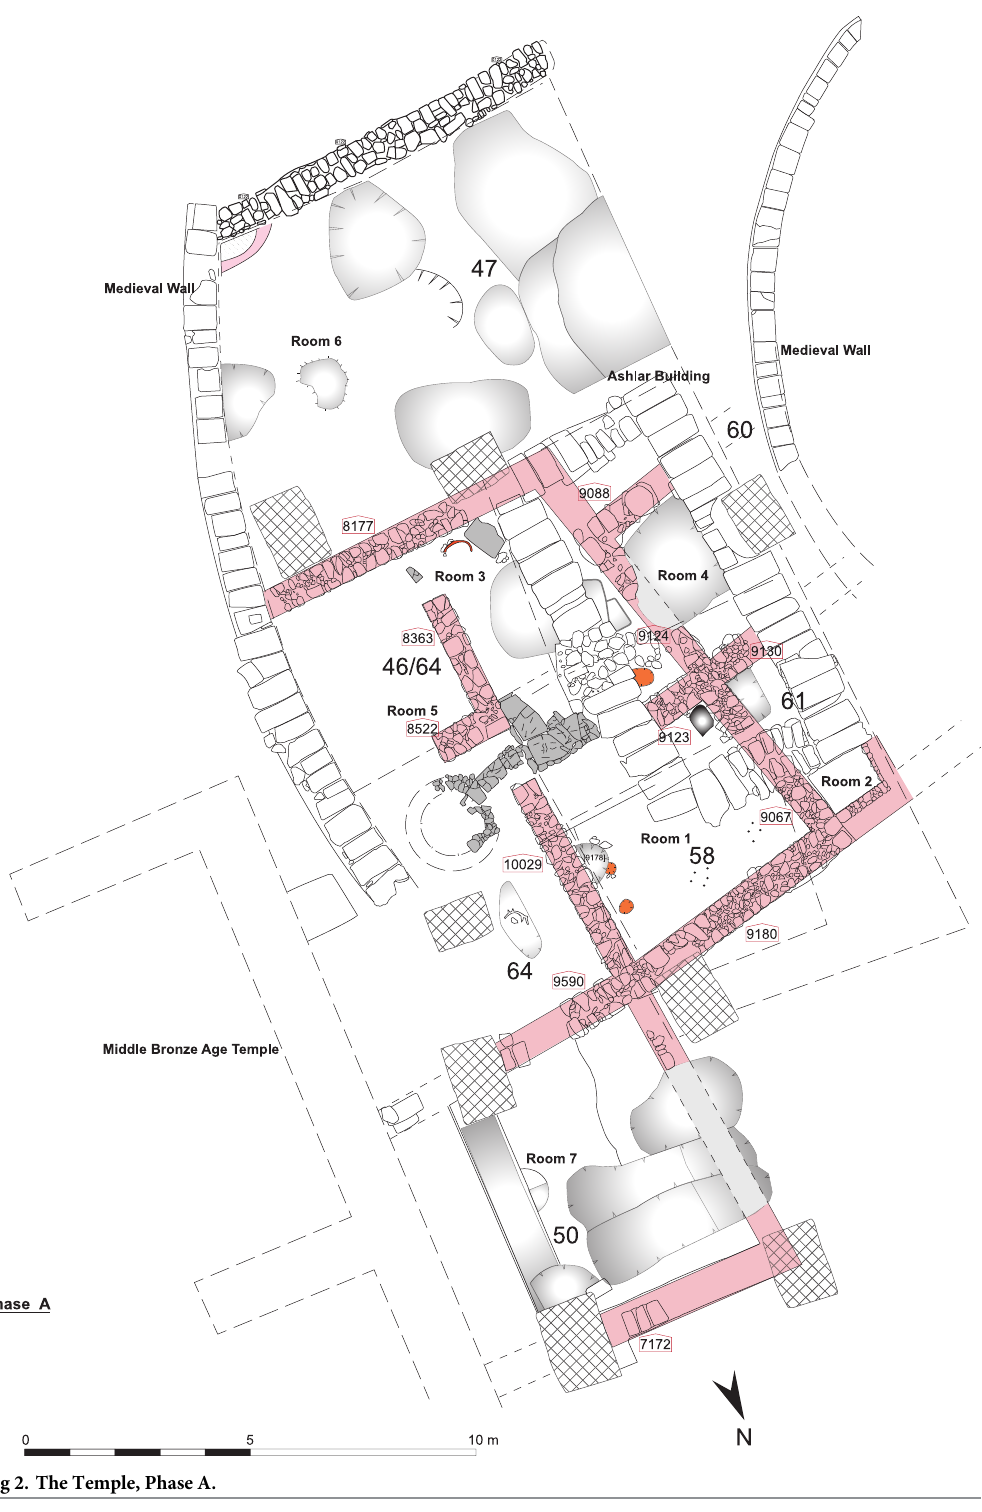
Fig 2. The Temple, Phase